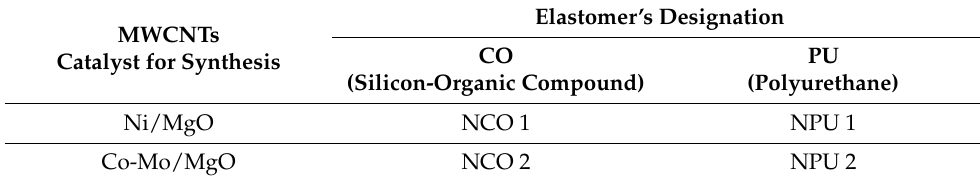
Table 1. Elastomers modified with MWCNT.